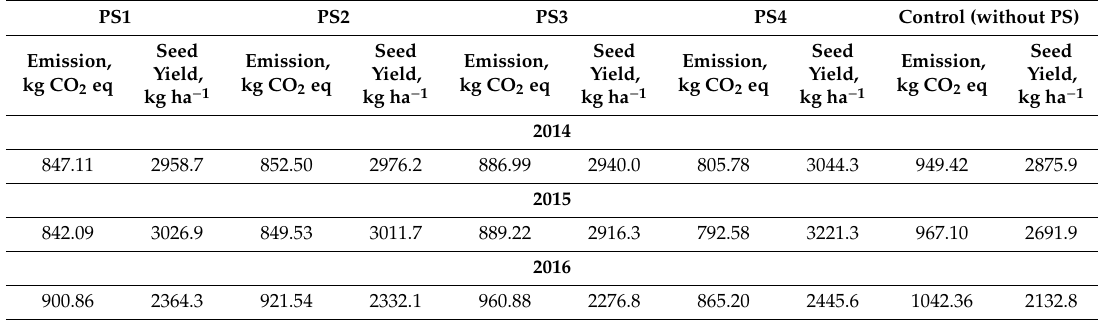
Table 6. Effect of pod sealant on global warming emission (kg CO 2 eq) and WOSR seed yield (kg ha − 1 ) in 2014, 2015, and 2016.